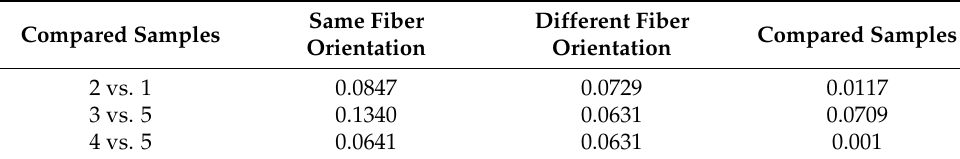
Table 7. Weight differences among similar Samples 1–5 (g). Figure 6. Weight loss in individual Samples 1 – 5 (X-orientation).